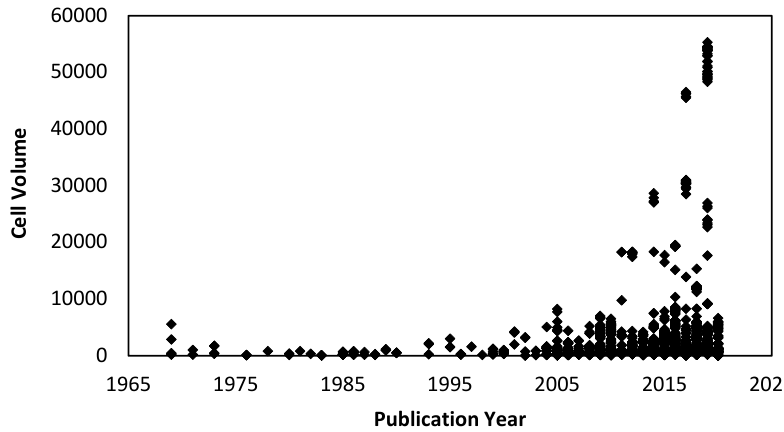
Figure 1. Cell volume versus publication year for all high-pressure structures collected in the Cambridge Structural Database (CSD) (version 5.41) that contain the required field ‘pressure’ in the cif.